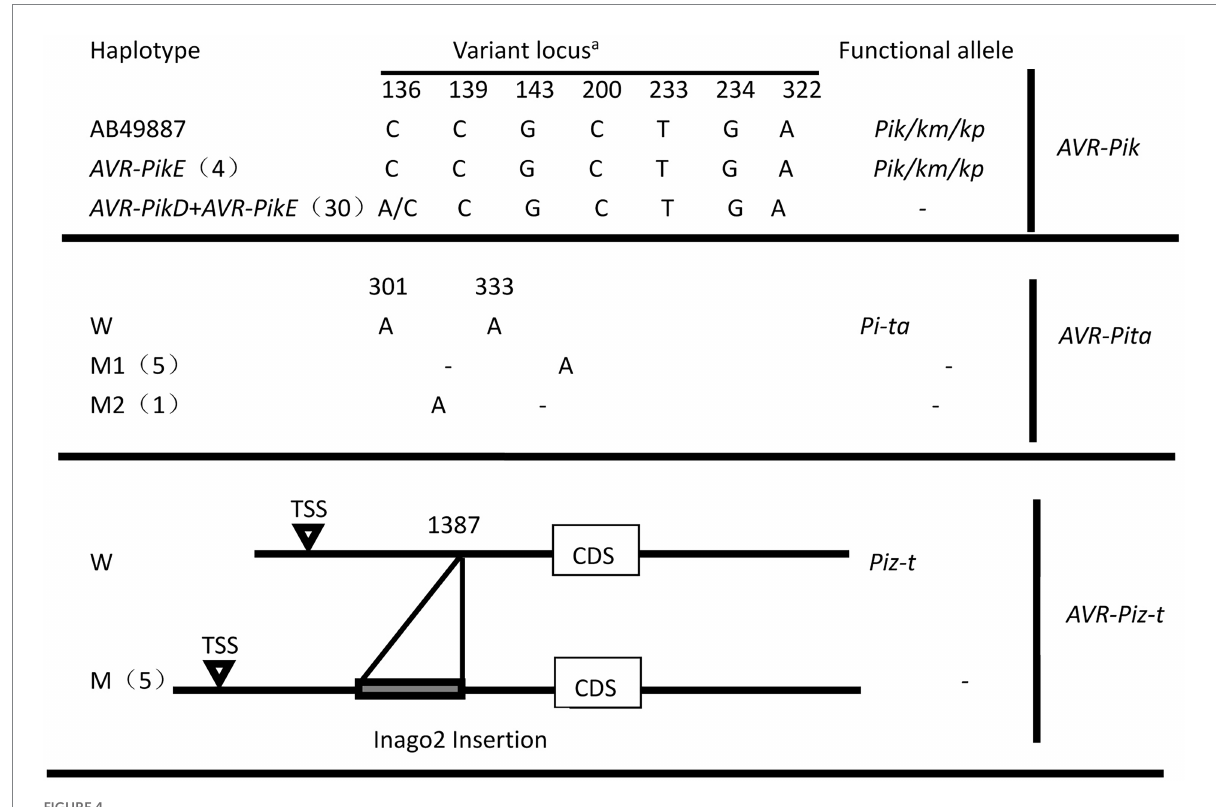
FIGURE 4 Characterization of allelic variations at AVR-Pik, AVR-Pita, and AVR-Piz-t. a The positions were based on the reference sequence of AVR-PikD (AB498875) , AVR-PikE (AB498879), AVR-Pita (AF207841), and AVR-Piz-t (EU837058). - , avirulent genes without resistance genes; W, wide type; M, M1, and M2, mutant